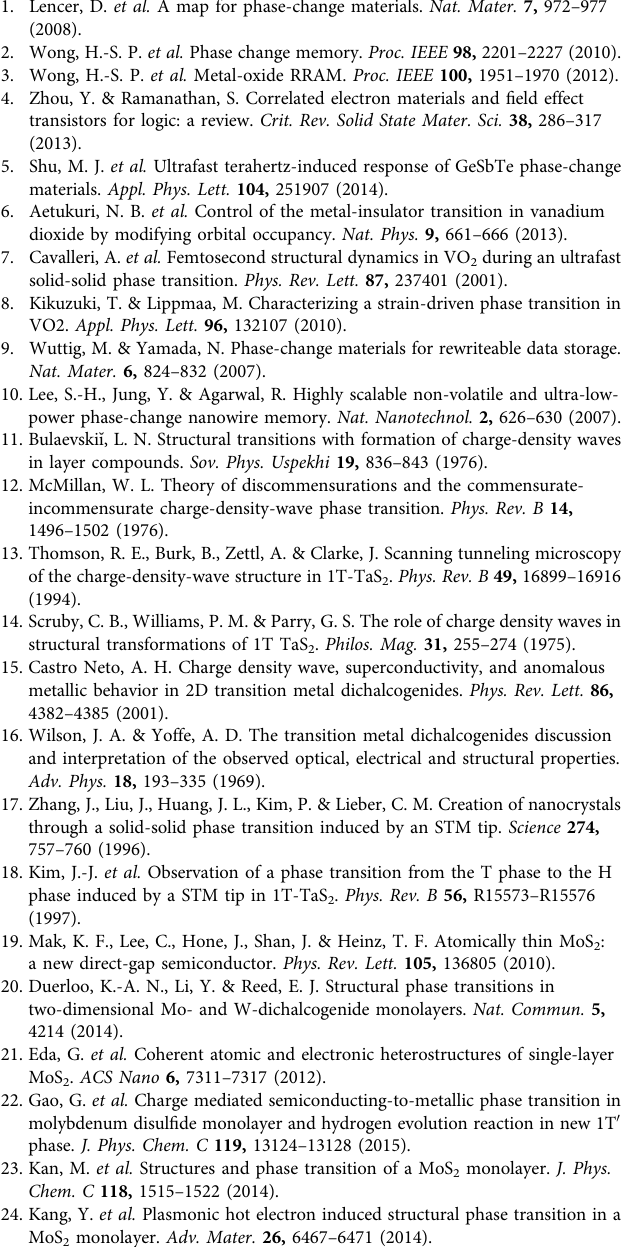
Figure 7 | Phase control of monolayer TaSe 2 through gating at constant stress. ( b ) Plotted is the computed phase diagram of monolayer TaSe 2 in the capacitor gating structure as shown in a . Unlike MoTe 2 , the phase diagram of TaSe 2 only has one phase boundary, which corresponds to a positive gate voltage. Below the phase boundary, 2H-TaSe 2 is more stable; above the boundary, 1T has lower energy and is more stable. Intuition for this qualitative difference from MoTe 2 is provided in Supplementary